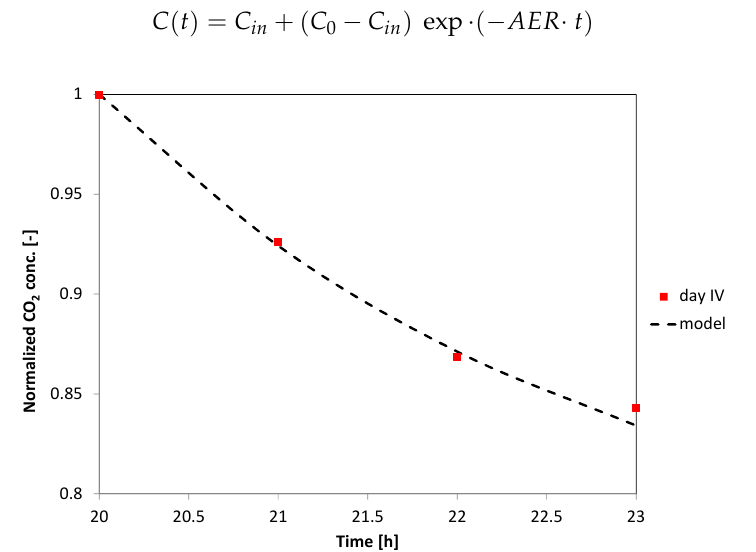
Figure 3. Model fitting of a normalized indoor CO 2 concentration trend during an unoccupied period for the estimation of the AER (naturally ventilated room).